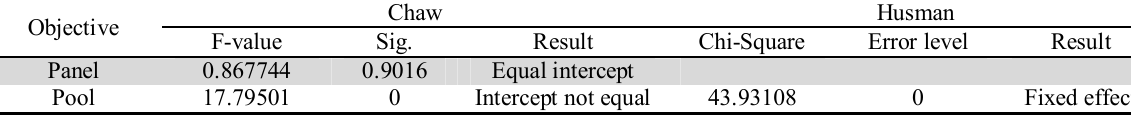
The summary of the results of Chaw and Husman tests Objective